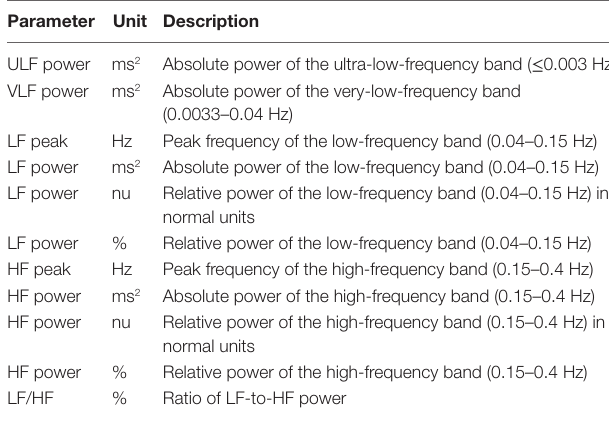
TABLe 2 | HRV frequency-domain